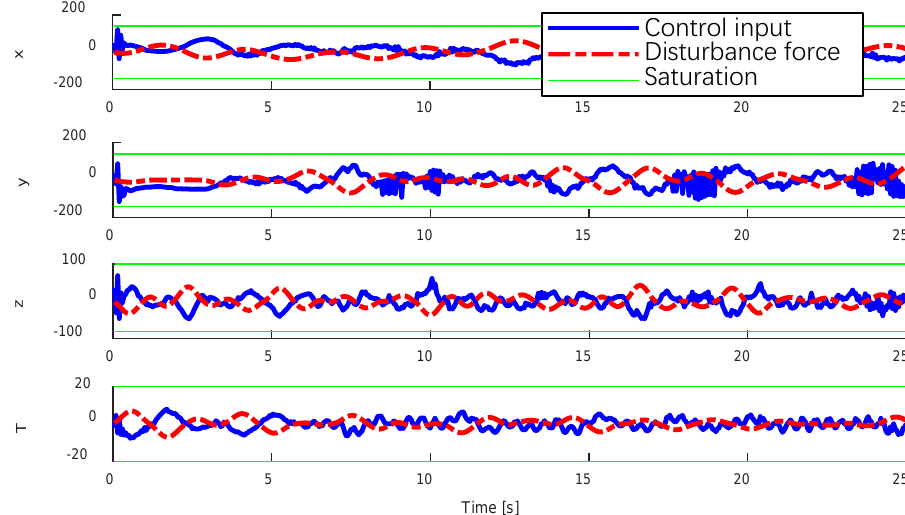
Figure 11. Disturbance effects and control